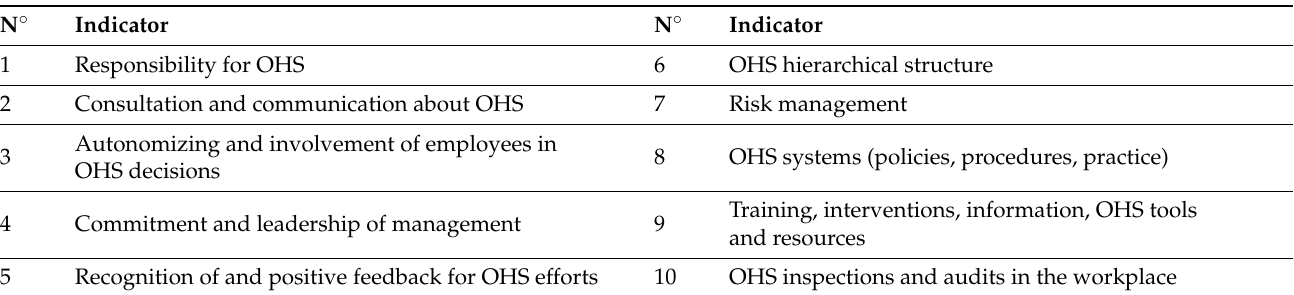
Table 10. Proactive indicators drawn from published studies